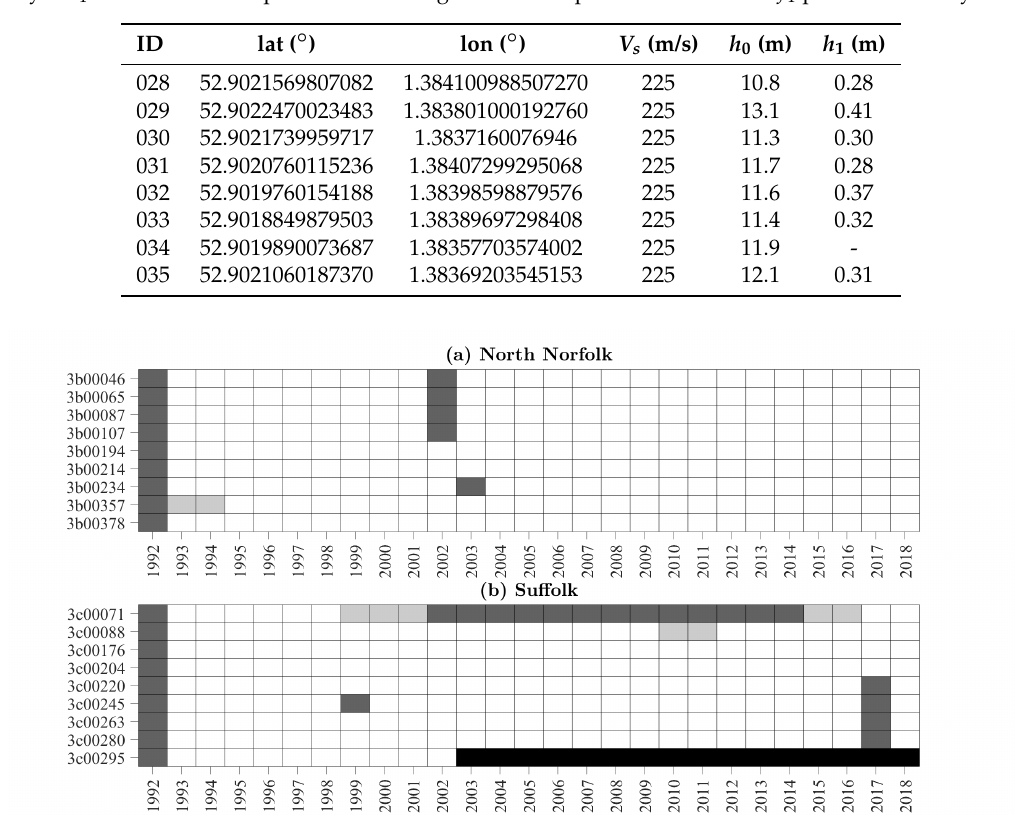
Figure A1. Incomplete profiles (light grey), missing profiles (dark grey), and new defence building (black) from the downloaded EA dataset: ( a ) North Norfolk, ( b ) Suffolk.